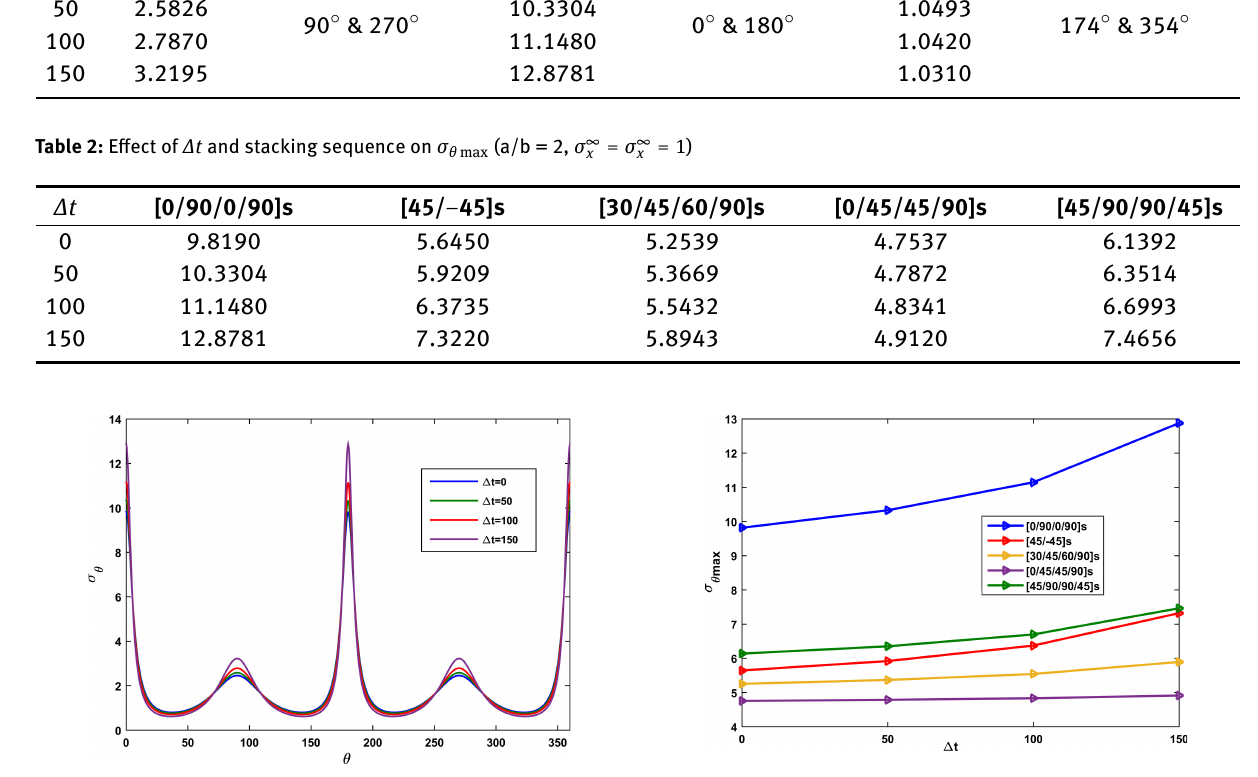
Figure 7: Effect of ∆t on σ θ max around elliptical hole in orthotropic plate subjected to for different stacking sequence and lamina fibre